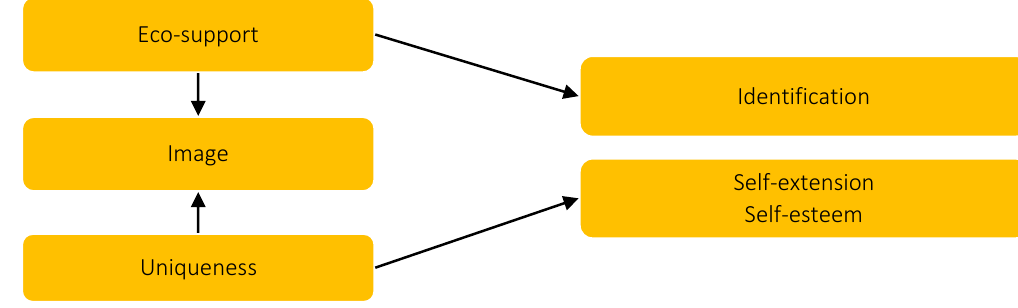
Figure 1. Relationship between research’s